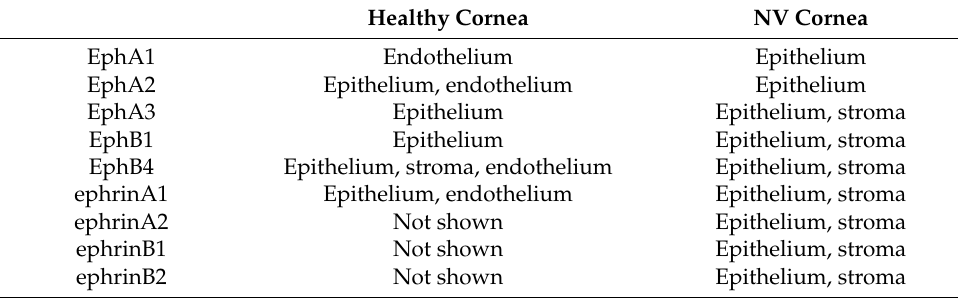
Table 1. Comparison of Eph and ephrin expression in normal and NV